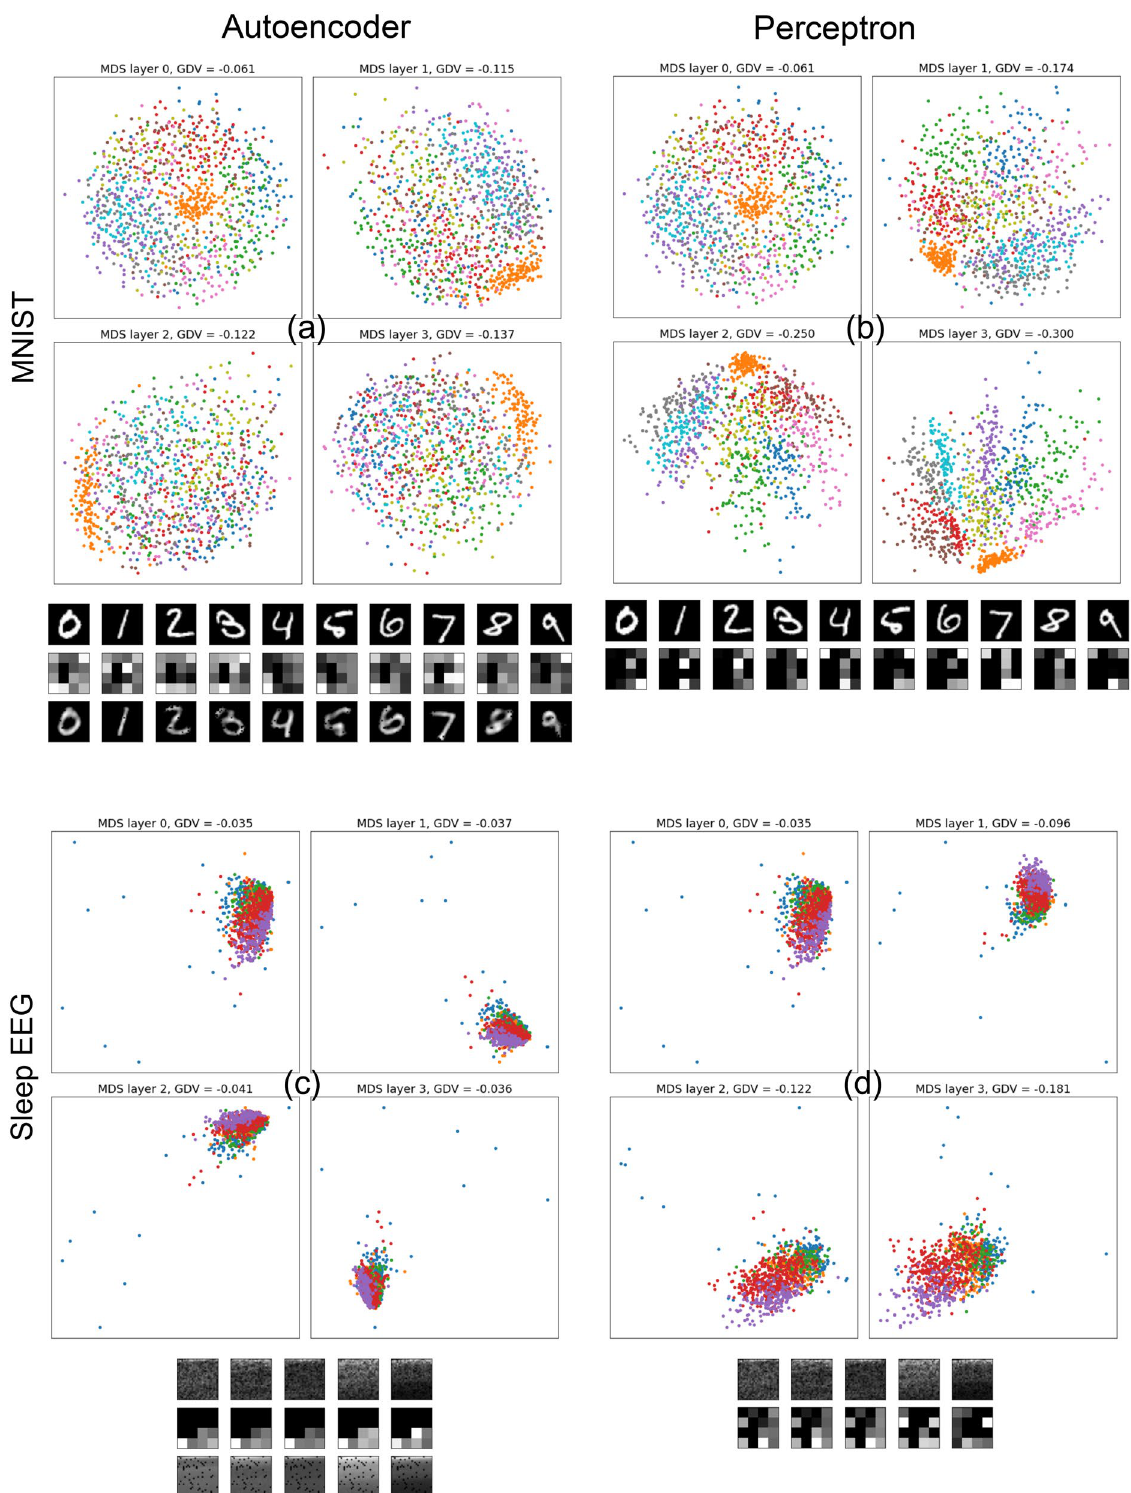
Figure 9. Clustering of natural data distributions in different network layers, after supervised and unsupervised training. As example data sets we use MNIST (upper part) and the Fourier amplitudes of EEG data recorded during sleep (lower part). As simple machine learning models we use an autoencoder (left part) for unsupervised training and a perceptron (right part) for supervised training. See method section for details of models and data pre-processing. For each combination (a,b,c,d) of model and data set, we show MDS projections of the data distributions in different layers of the network, with data classes marked by colors. The degree of class separability is quantified by the GDV in the titles of the MDS plots. Additionally, we show example input patterns (as 28x28 pixel arrays) for each data class, together with their representations in the smallest network layer 3 (as 4x4 pixel arrays). In the case of the autoencoder, we also show the reconstructed